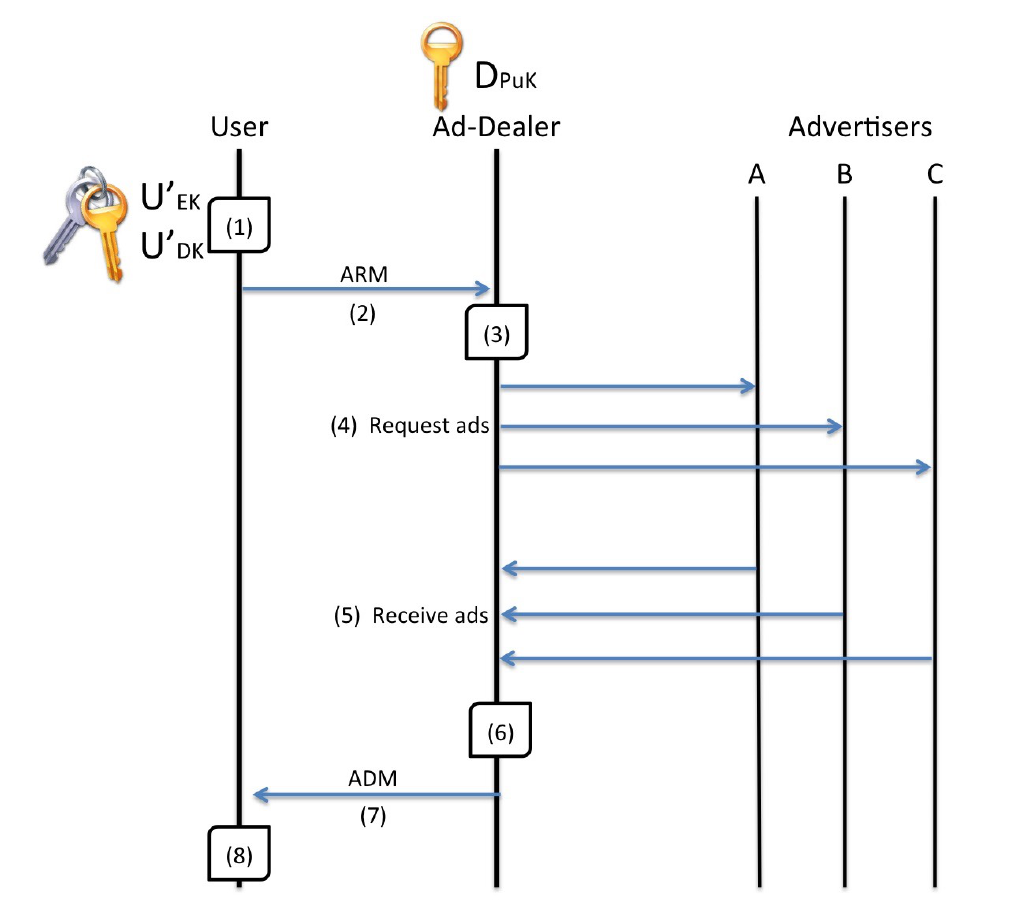
Figure 11. Advert Collection